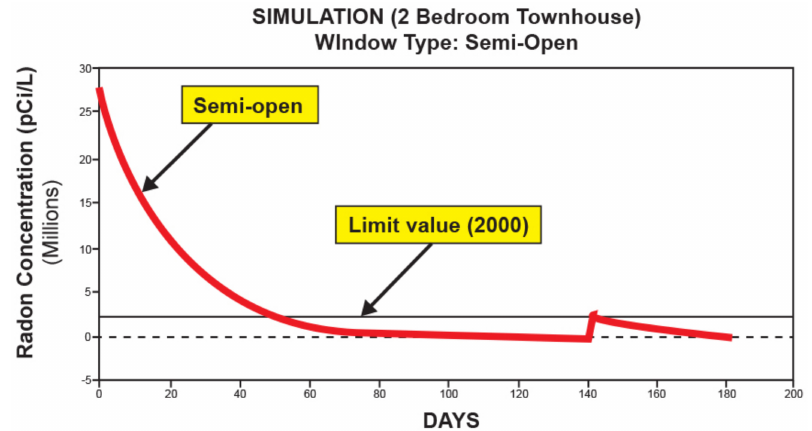
Figure 2. Changes in radon concentration with window semi-open.